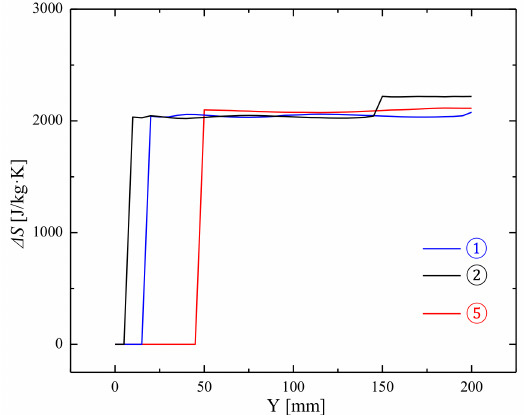
Figure 12. Variations in ∆ S along the three typical streamlines in an axial